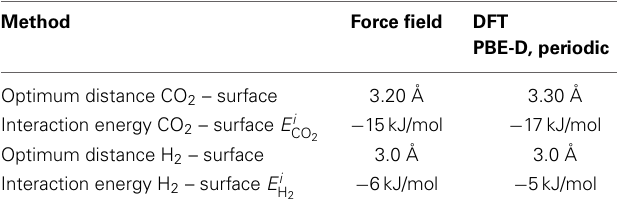
Table 2 | Optimum distance for adsorption and corresponding interaction energies for the FF and DFT methods used.